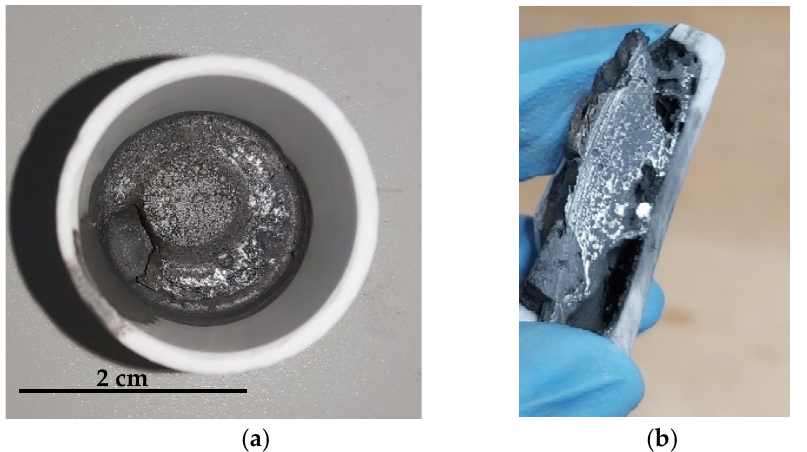
Figure 6. Sample after melting and cooling down of the iron rich solid residue (resulted from the water leaching of the initial thermal product) ( a ) from the furnace and ( b ) the cross-section after the crucible was cut.